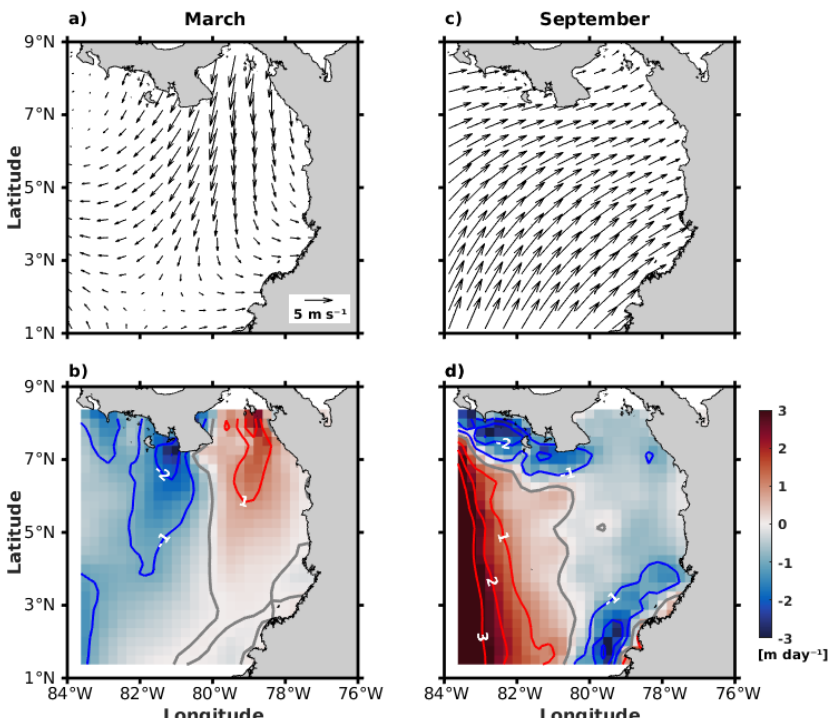
Figure 4. Climatology (2002–2016) of wind velocity (top panels) and Ekman pumping (bottom panels) for ( a , b ) March and ( c , d ) September. Red shading represents the regions of upward Ekman velocities (upwelling), and blue shading indicates downward velocities (downwelling). The gray contours denote where vertical velocities are equal to zero.